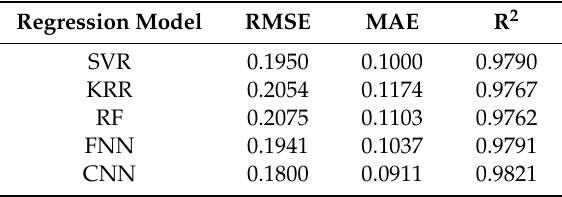
Table 1. RMSE (eV / atom), MAE (eV / atom) and R 2 values of cross-validation results of all prediction models using the OFM